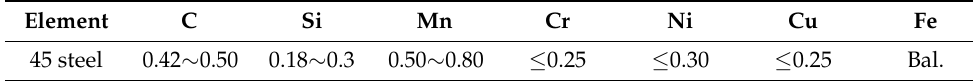
Table 1. Chemical composition of 45 steel (mass fraction, %).